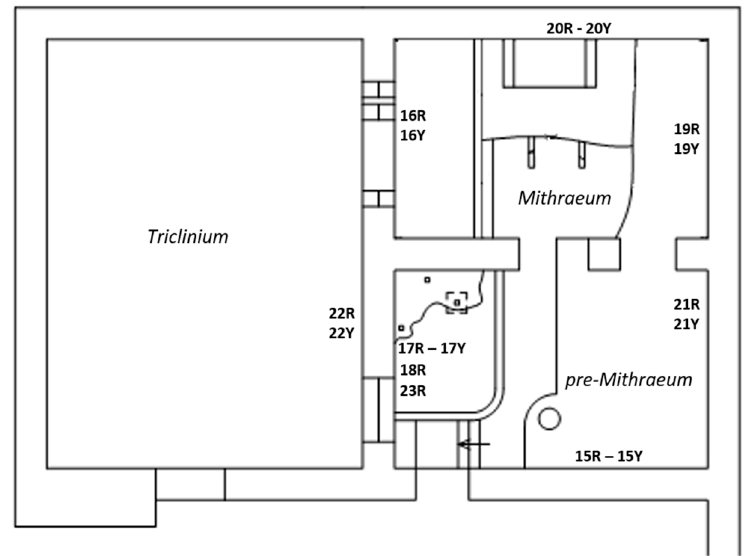
Figure 2. Plan of the building and measuring points.